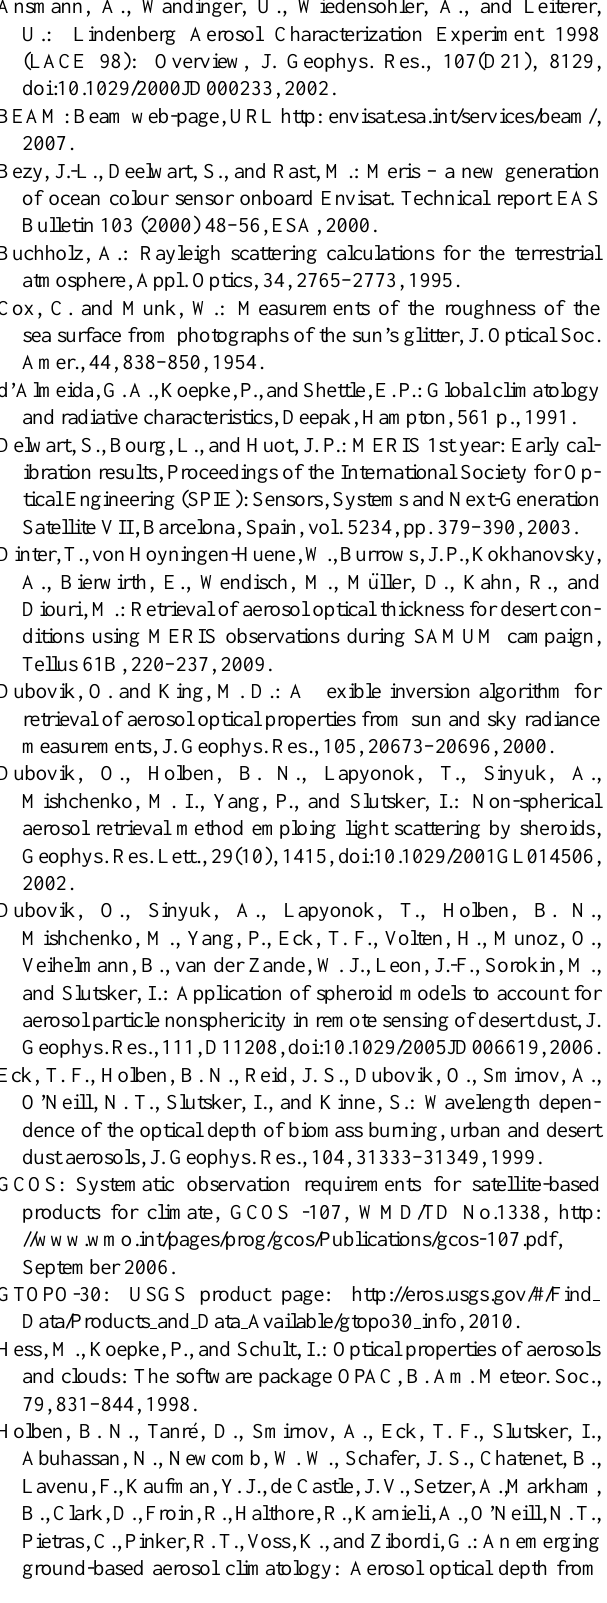
Table 6. Average annual change in AOT for selected regions of